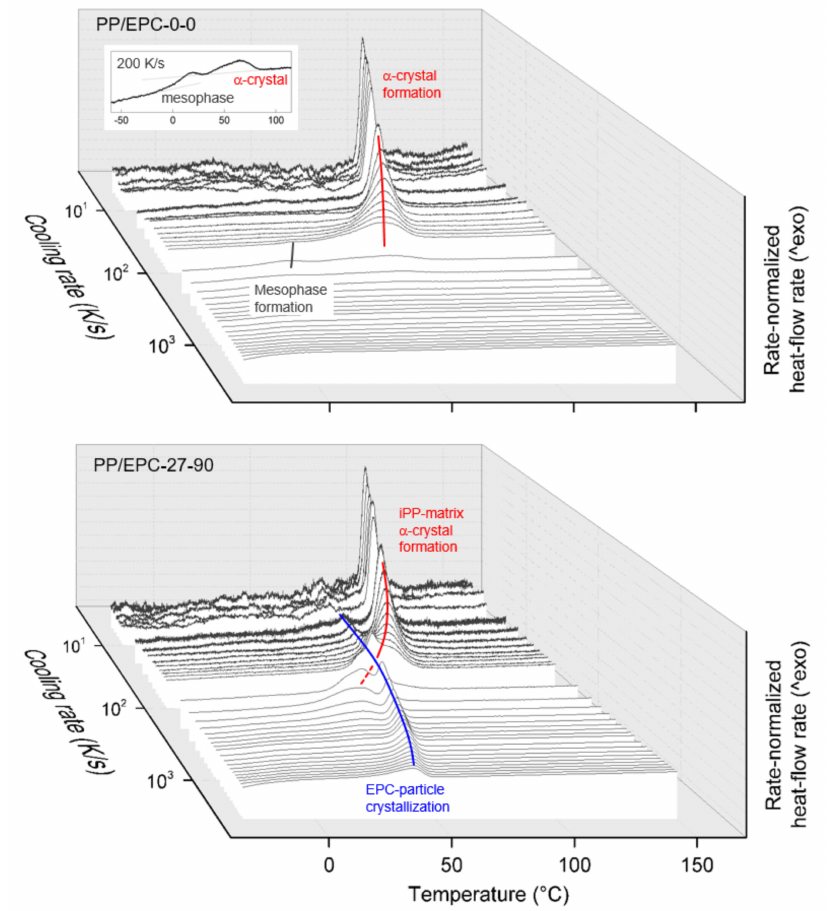
Figure 1. Sets of rate-normalized FSC cooling curves of the samples PP / EPC-0-0 (iPP homopolymer) (top) and PP / EPC-27-90 (heterophasic iPP containing 27 wt % EPC particles with 90 wt % ethylene counits) (bottom). Exothermic heat-flow rate is directed